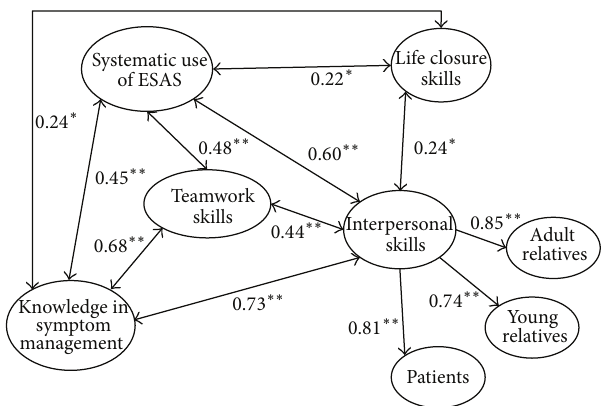
Figure 1: The correlation between the factors in the NCPC instru- ment. Only correlations above 0.20 is presented. (Note: 𝑡 𝑃 < 0.1 , ∗ 𝑃 < 0.05 , ∗∗ 𝑃 < 0.01